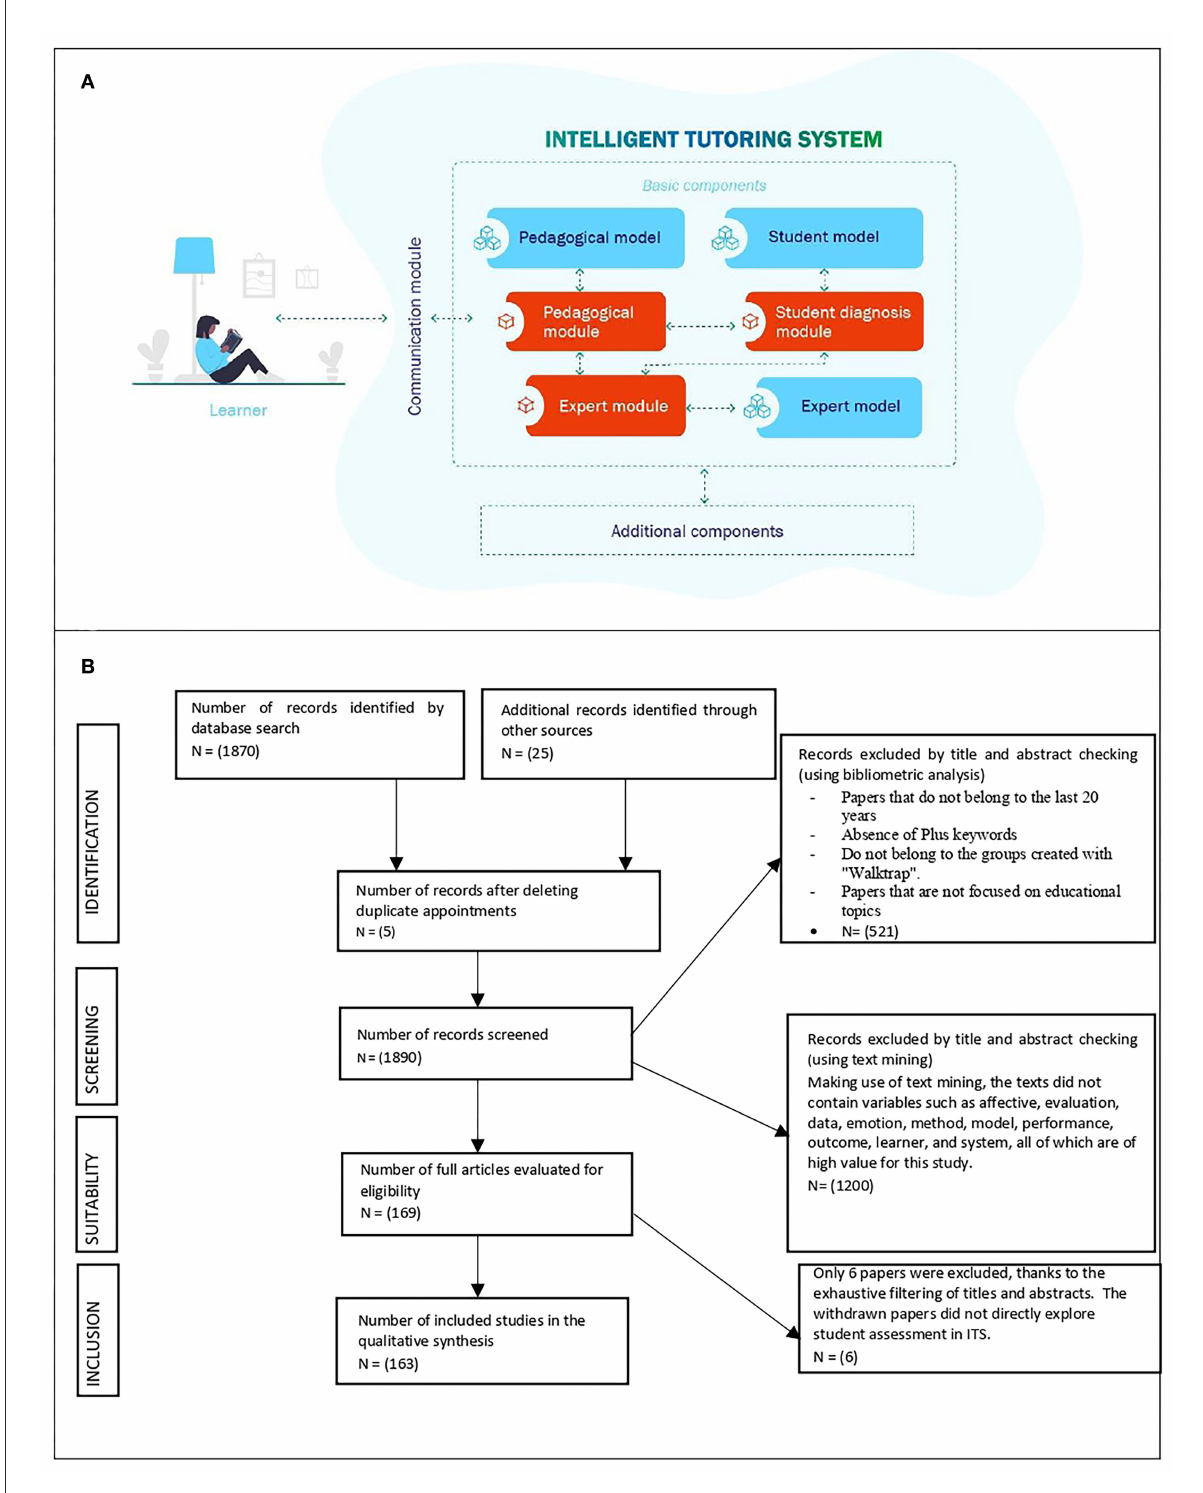
FIGURE2 (A) ITS Basic components. Adapted from Anohina (2007) and Al-Hanjori et al. (2017) and (B) the process of PRISMA for data collection and